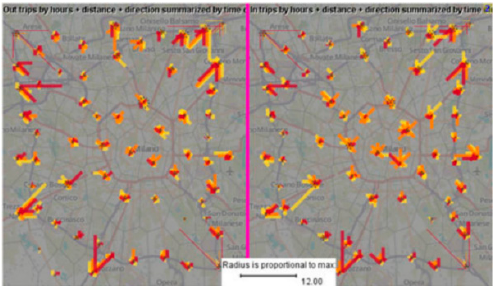
Figure 52. Traffic-flow visualization of driving data in Milan, with the spatial patterns between sites [132].